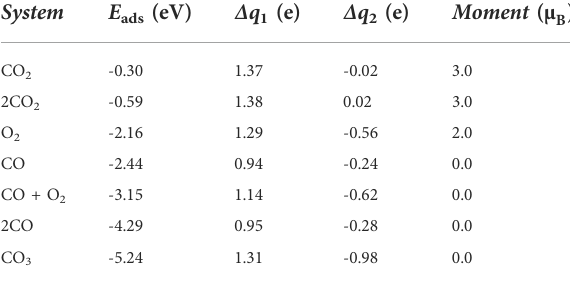
TABLE1Therelated parametersofgasmoleculesabsorbed onFe@ χ 3 - borophene: adsorption energy (E ads ), charge transfer between the Fe atom and the χ 3 -borophene ( Δ q 1 ), charge transfer between gas molecules and Fe@ χ 3 -borophene ( Δ q 2 ), magnetic moment of the